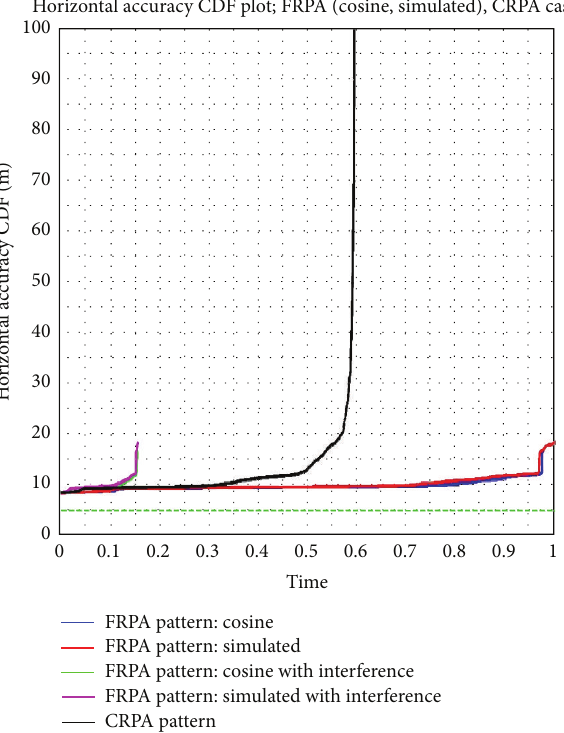
Figure 20: Horizontal accuracy CDF curve − 24/24GPS constella- tion and 4RF interfering